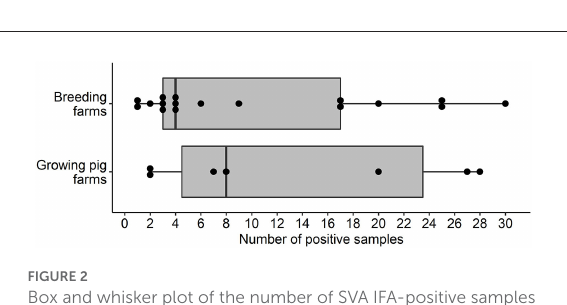
FIGURE2 Box and whisker plot of the number of SVA IFA-positive samples by pig farm type in the